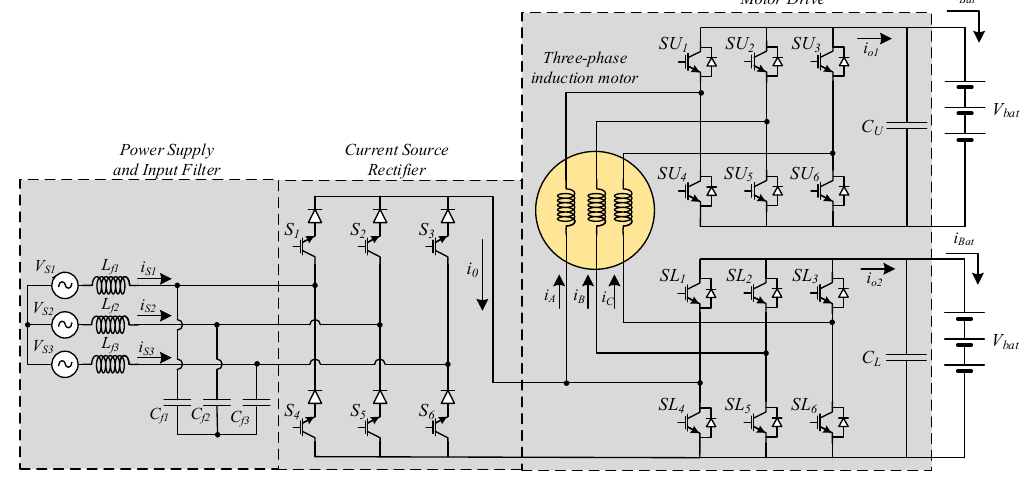
Figure 1. Power converter topology for the three-phase integrated battery charger of an electronic vehicle (EV) with a dual-inverter drive.